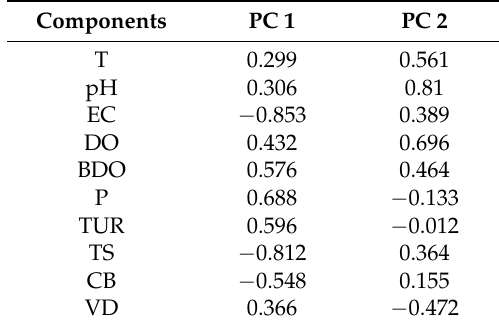
Table 4. Weights of the variables for PC1 and